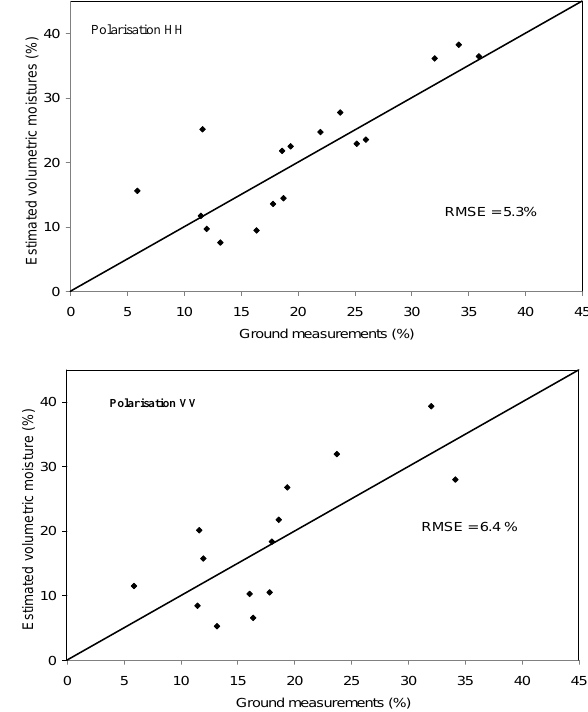
Fig. 8. Soil moisture estimations from ENVISAT ASAR data, ver- sus soil moisture derived from ground truth measurements, for dif- ferent test wheat